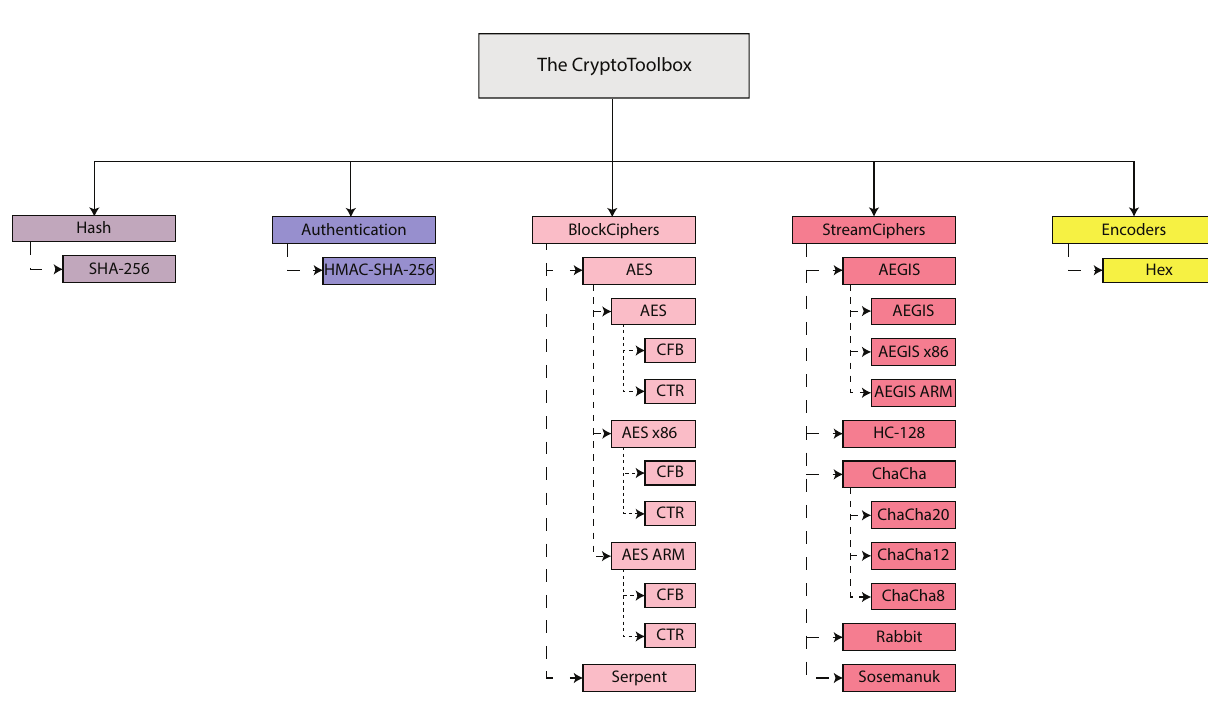
Figure 3: An overview of the algorithms available through the